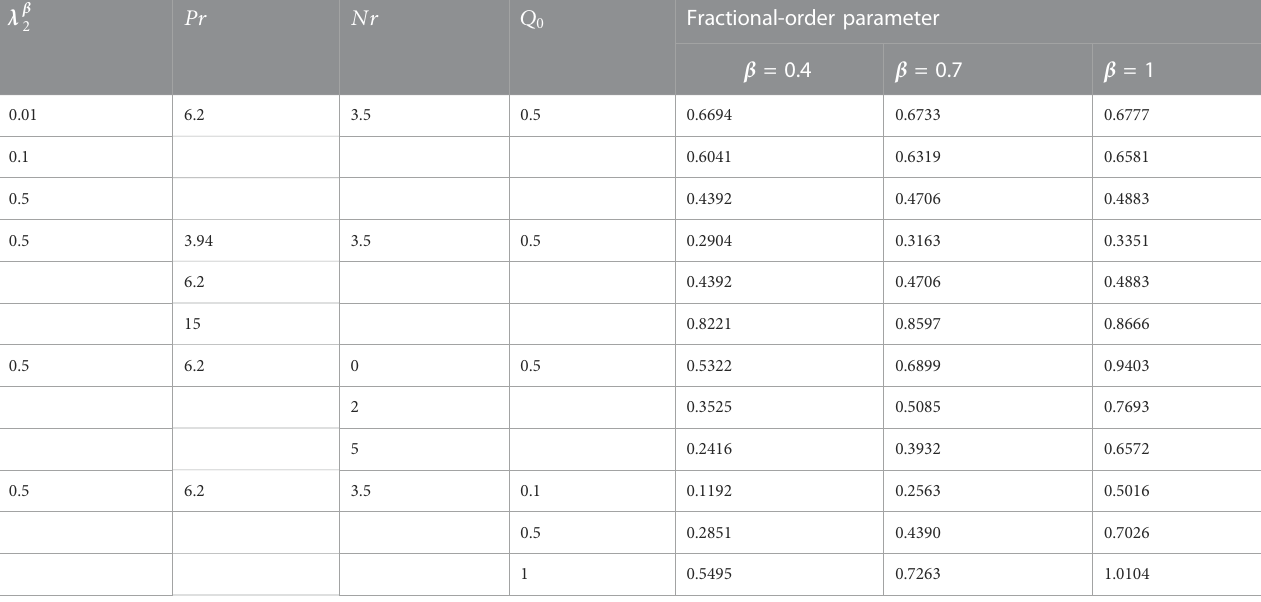
TABLE 3 Variation in the local Nusselt number with respect to varying physical parameters and α